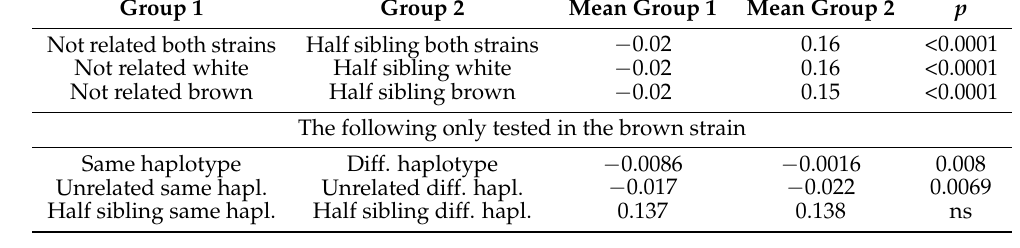
Table 6. Means of g and p -values of compared groups with different haplotype and relationship statuses.